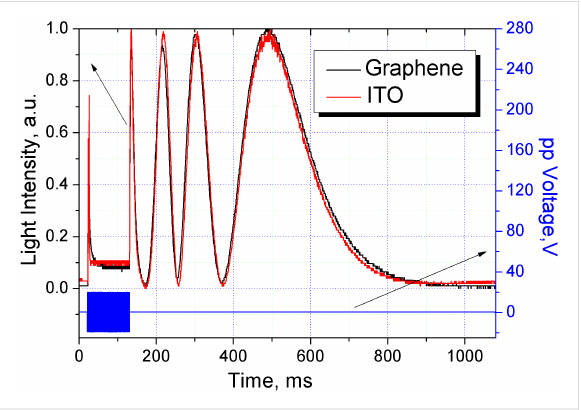
Figure 6: Time dependence of the intensity of light passing through the LC cells with graphene and ITO